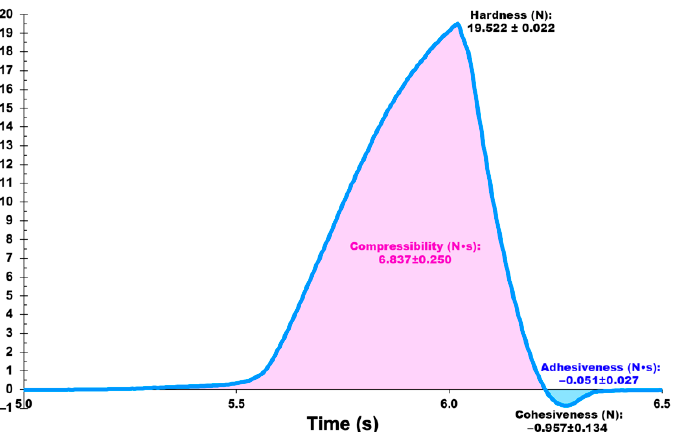
Figure 15. Force-time curve of texture profile analysis together with the results obtained for the mechanical properties of the vaginal egg formulation integrating the cocktail of lytic bacteriophage particles, viz. compressibility, hardness, adhesiveness and cohesiveness.